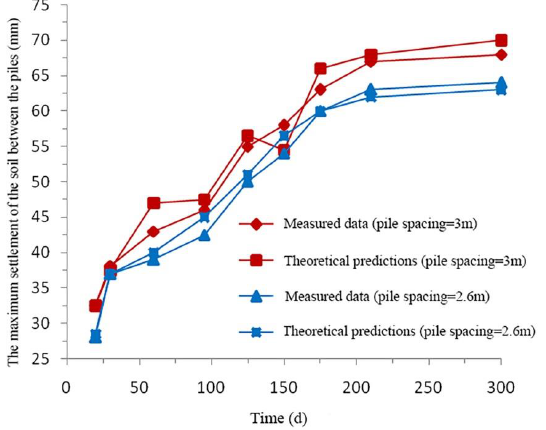
Figure 19. The time-dependent maximum settlement of the soil between the piles with different pile spacings.